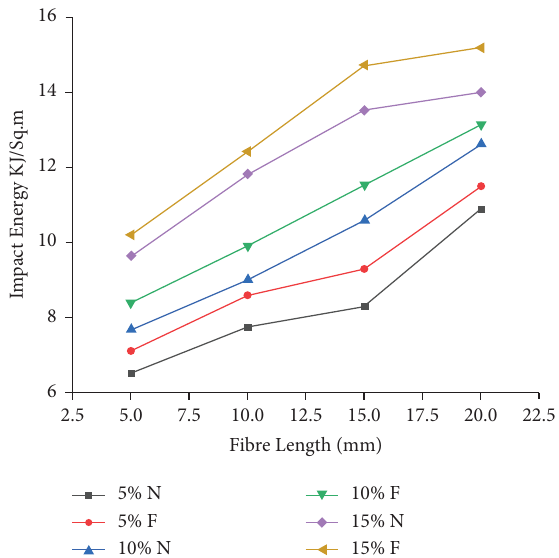
Figure 5: Impact strength variation for diferent fbre wt.% and length (N-neat (without fller) and F (with fller)). Table 1: Water absorption test results for banana fbre composite (20 mm length). Banana fbre content by